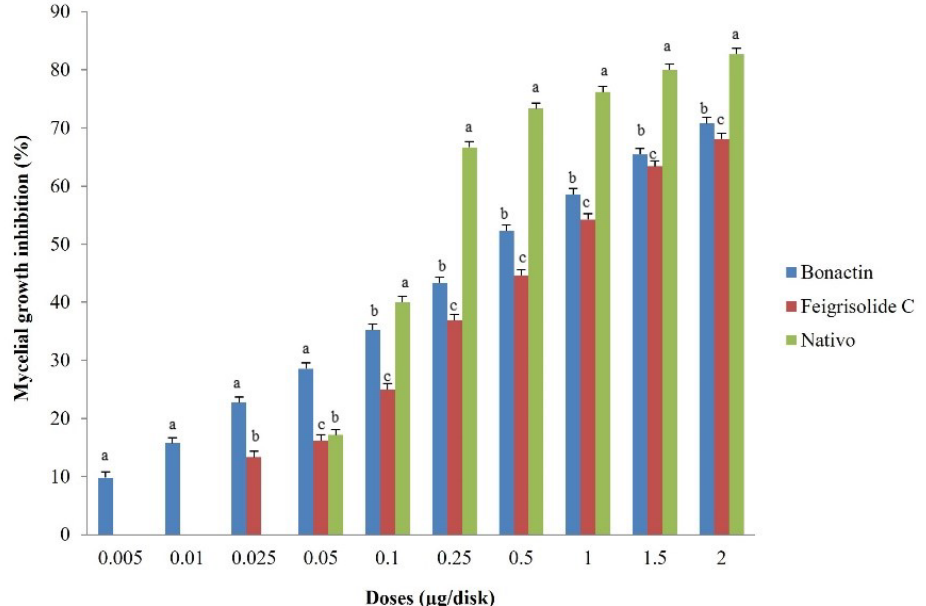
Figure 2. Suppression effects of bonactin, feigrisolide C, and Nativo ® WG75 on mycelial growth of Magnaporthe oryzae Triticum (MoT) isolate BTJP 4 (5) in PDA media. The data represents the mean ± standard errors of three replications for each rate of the test compound based on the Tukey HSD (honest significance difference) test at a 5% level.